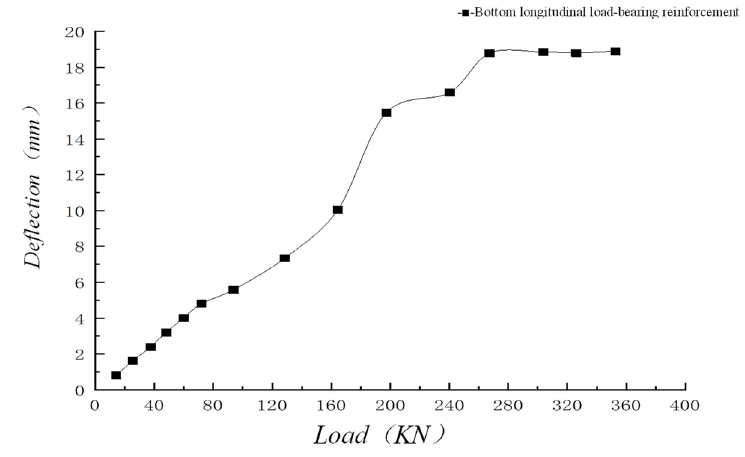
Figure 32. Load − deflection curve of cross − middle tension steel.